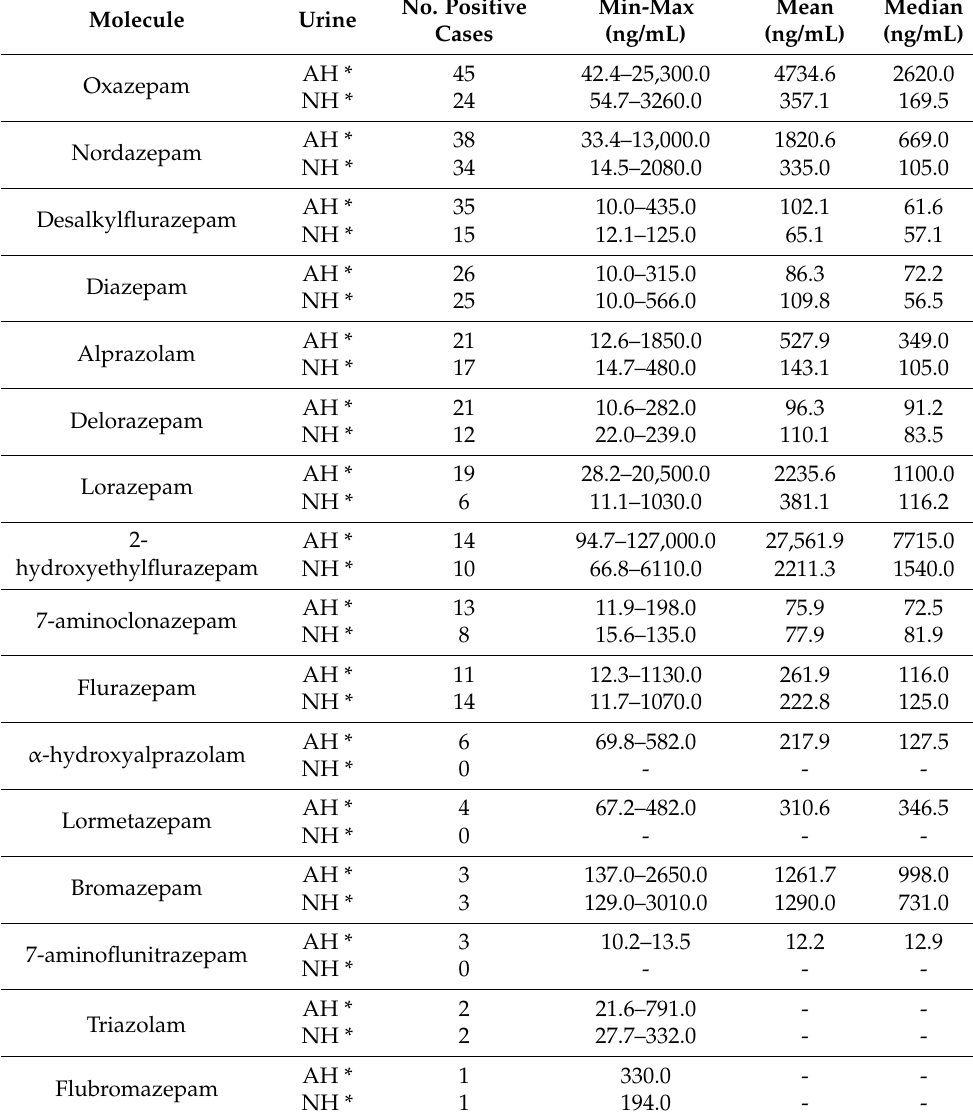
Table 1. LC-MS/MS results from urine